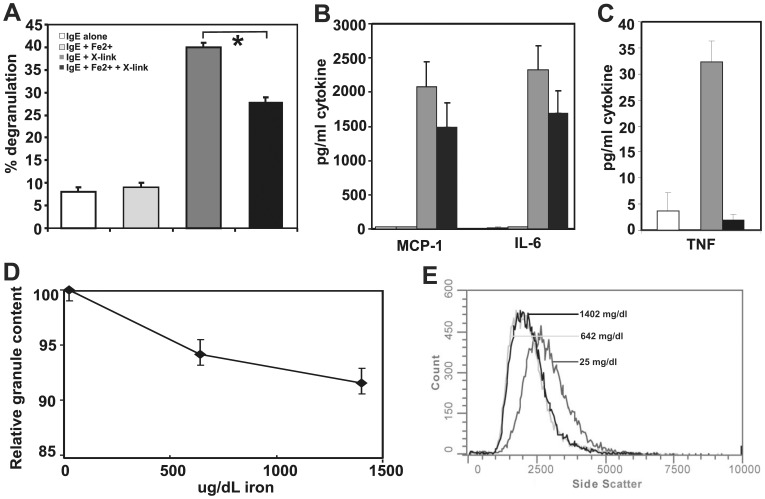
Effects of iron supplementation on IgE-mediated mast cell degranulation, cytokine production, and total granule content.
A. Supplementation with iron decreased degranulation of primary BMMC by 30% (*indicates p = 0.01). Data shown is the mean ± SEM of 4 experiments. B, C. In duplicate experiments, iron supplementation decreased mast cell production of TNF, MCP-1, and IL-6 by 94%, 29%, and 27%, respectively. An MTS assay confirmed continued viability of the BMMC (not shown). D, E. RBL-2H3 mast cells showed a dose-dependent reduction in total granule contents per cell with iron supplementation, as indicated by β-hexoseaminidase activity following lysis with Triton X-100 (panel D) and flow cytometric analysis of side scatter (panel E). Data shown represents the mean ± SEM of 3 − 4 independent experiments, each conducted in triplicate. *indicates p≤0.02.